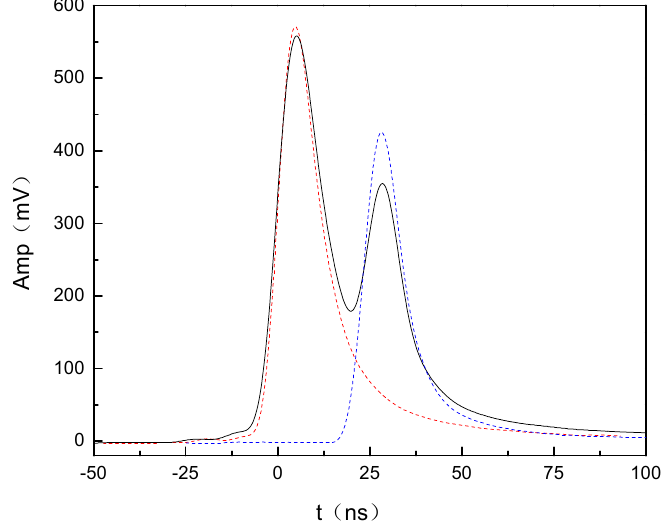
Figure 3. Example signal waveform of 1.4 × 1.4 mm 2 EQR SiPM. The red dashed line was for the path 2 being blocked; the blue dashed lines was for the path 1 being blocked; the black line was for two paths being connected.